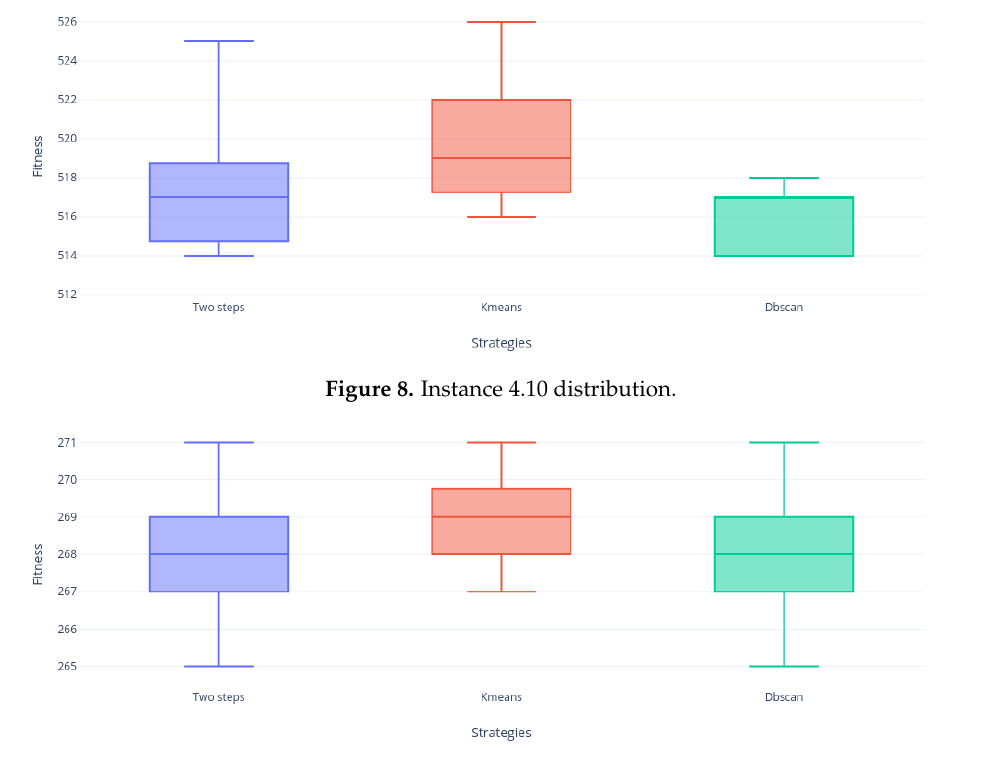
Figure 9. Instance 5.10